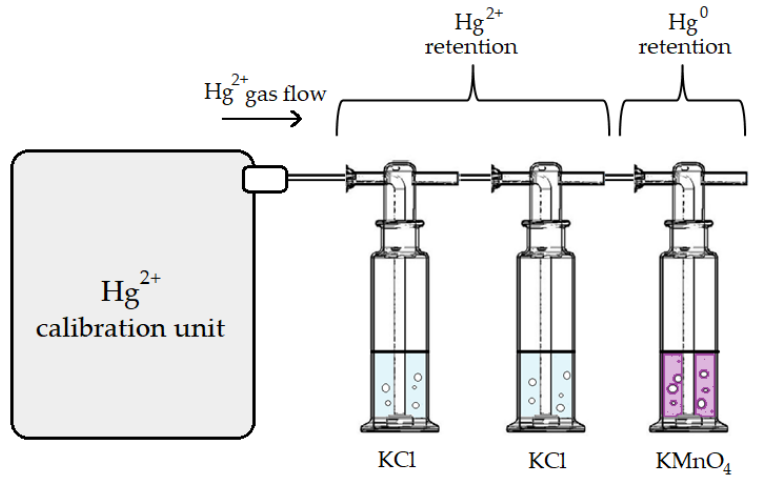
Figure 2. The three-impinger setup used for capturing the HgCl 2 gas output of the calibration unit (objects not shown to scale).